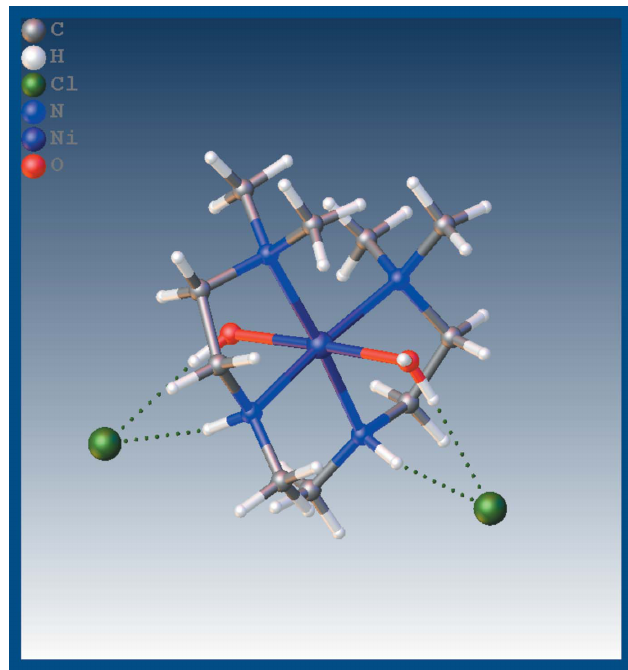
Figure 1 A view of [Ni(C 5 H 16 N 4 O 2 ] 2+ 2Cl (cid:3) , showing its structure generated from two asymmetric units containing half of the cation complex and a chloride ion situated about a twofold rotation axis on the Ni II ion. The green dotted lines represent hydrogen